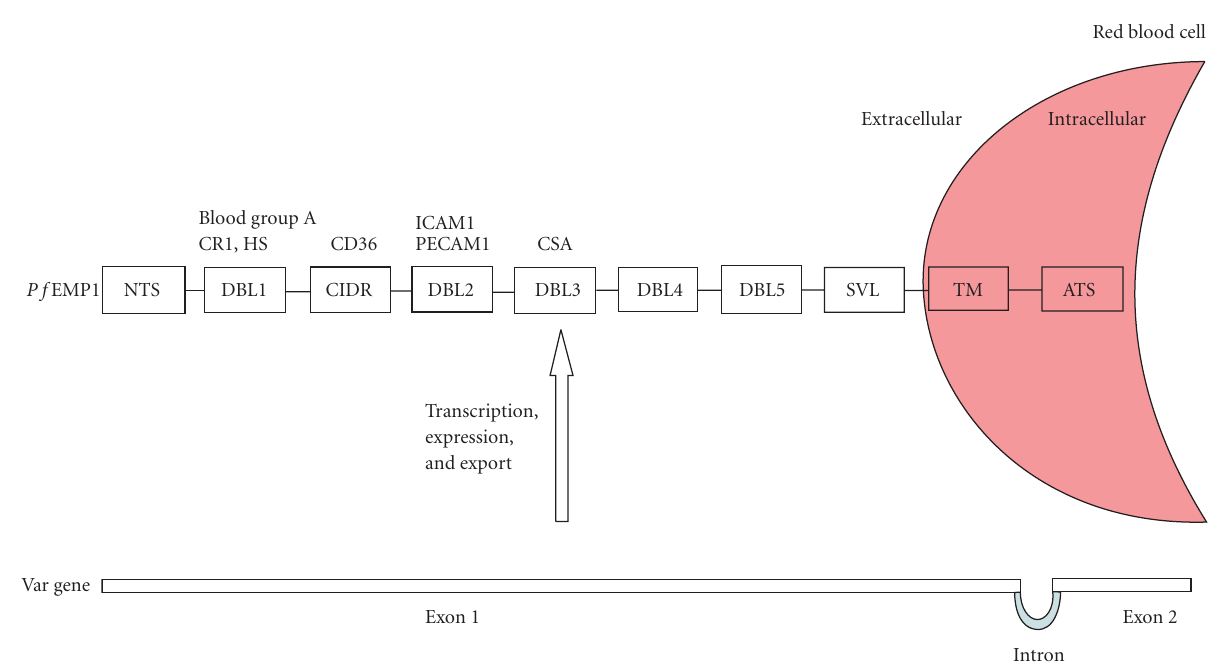
Figure 3: Schematic diagram illustrating var gene and P f EMP1 organization. Domains with known binding properties are specified. NTS, N -terminal sequence; DBL, Du ff y-binding like; CIDR, cystein-rich interdomain; SVL, sequence of variable length; TM, transmembrane; ATs, acidic terminal